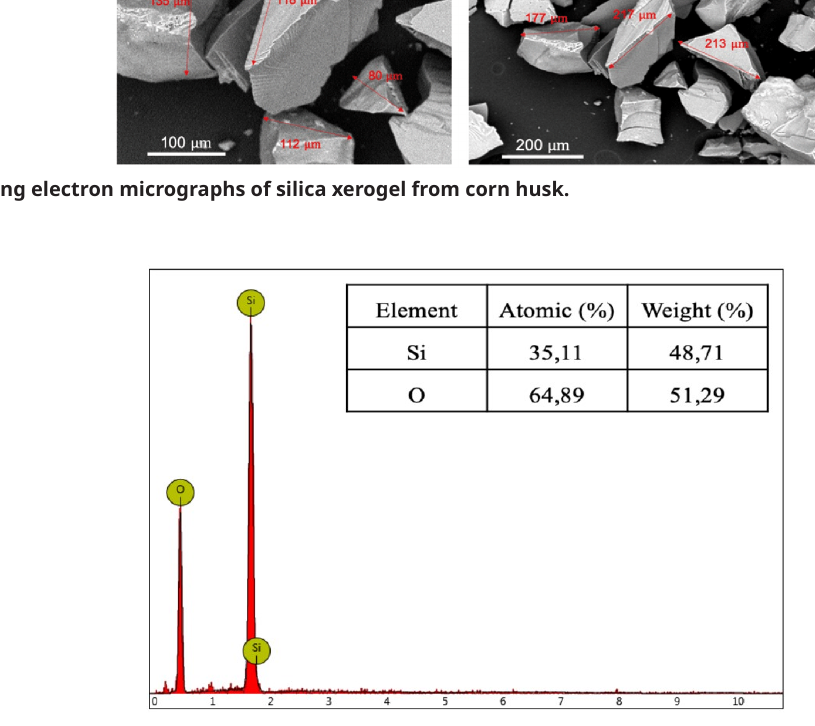
Figure 5. Energy dispersive X-ray spectra and composition of silica xerogel from corn husk.